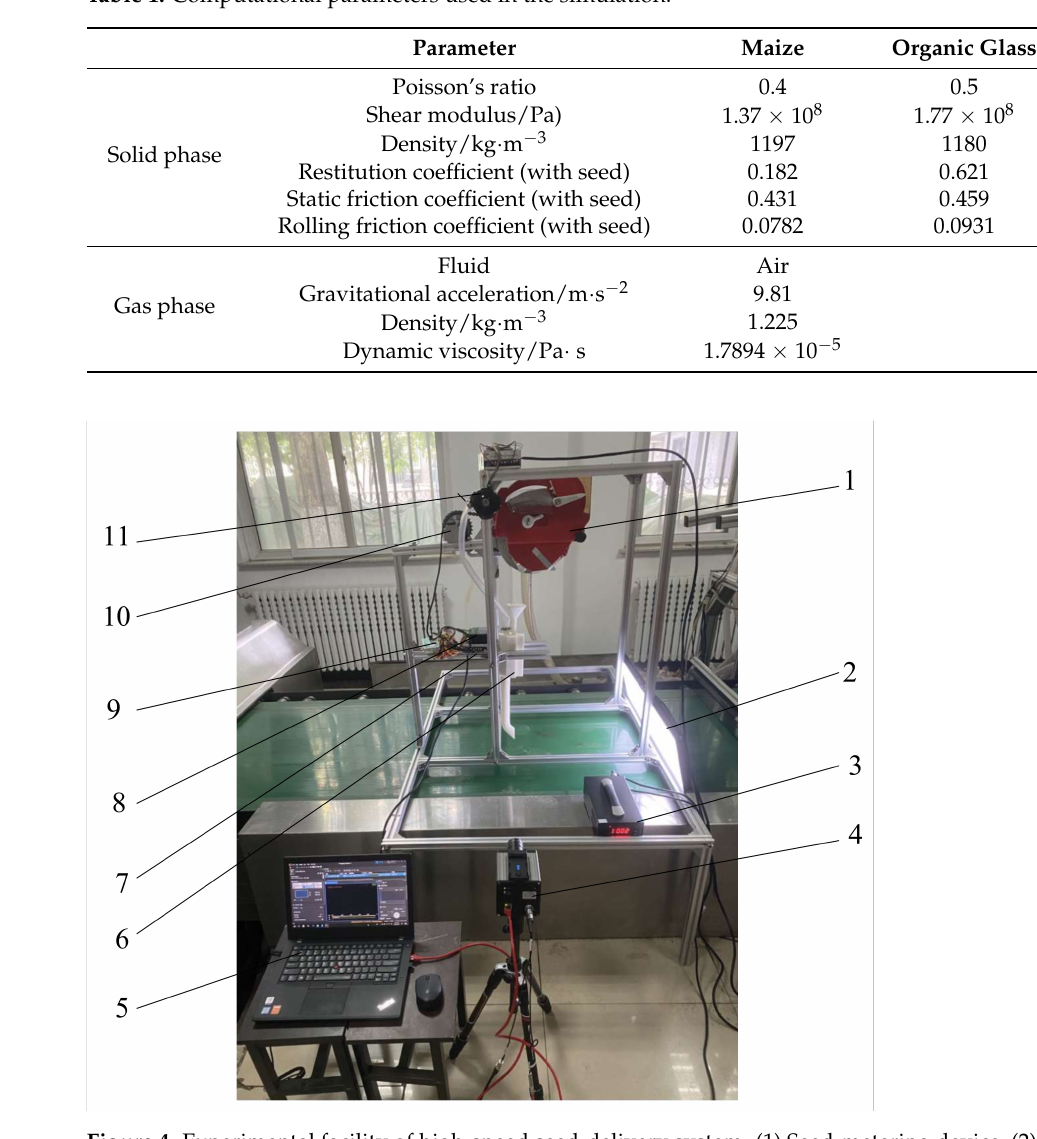
Figure 4. Experimental facility of high-speed seed-delivery system. (1) Seed-metering device, (2) fill light, (3) controller of fill light, (4) L-PRI 1000 high-speed camera (produced by AOS Technologies AG, with a frame rate of 500 frames per second during the test), (5) PC, (6) seed-delivery system, (7) power source, (8) drive, (9) controller, (10) stepper motor, (11)